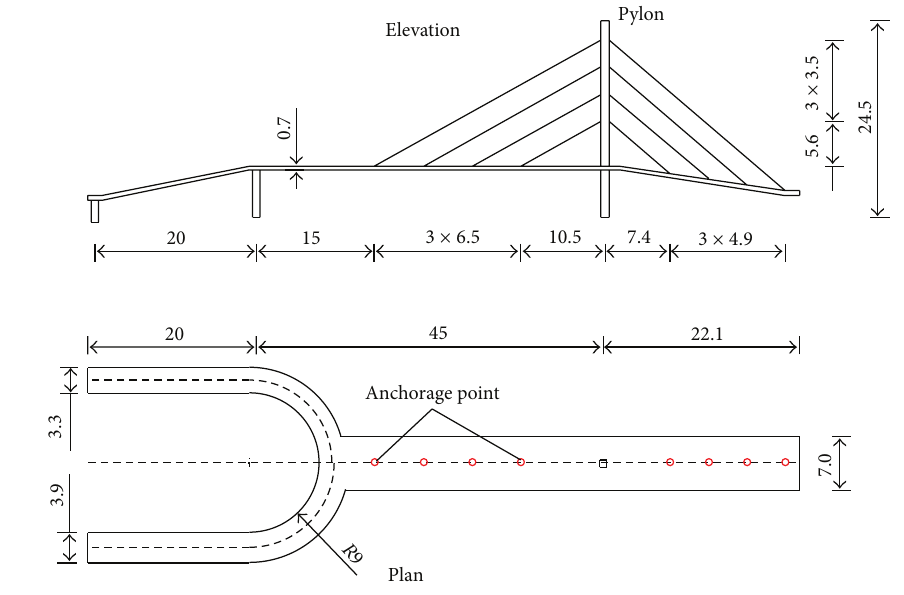
Figure 5: The elevation and plan of the footbridge (dimensions are in m).